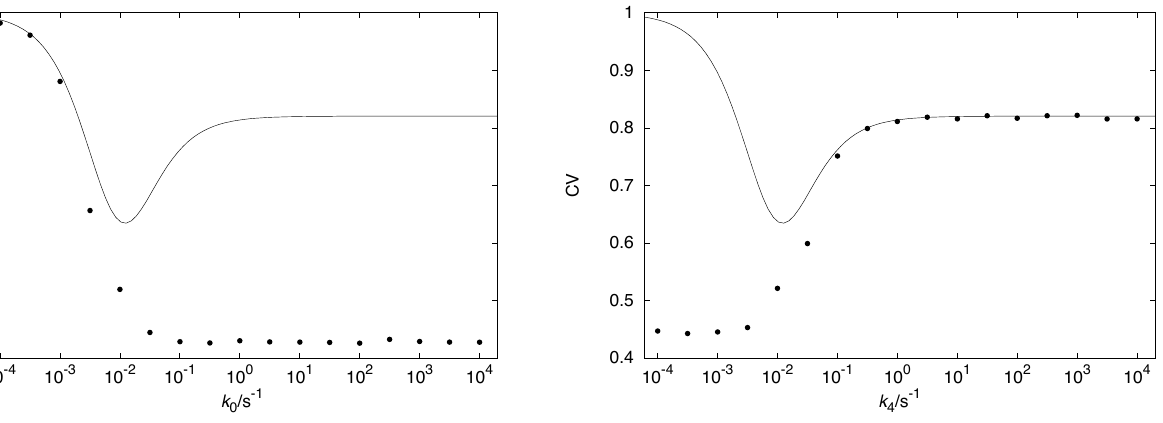
Fig. 8. CV vs k 4 . All parameters and simulation conditions are as in figure 7, except k 0 = 0 . 01 s − 1 . The solid curve is the CV computed from the analytic theory, i.e. equation (34). The points are from stochastic